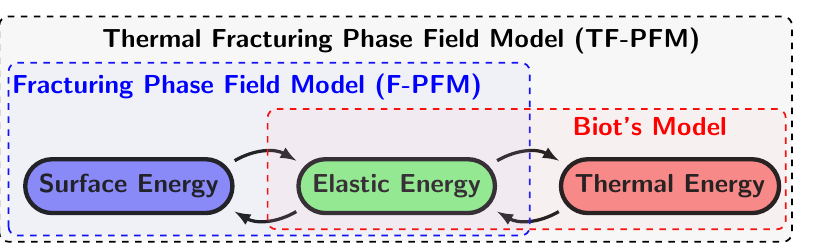
Figure 1. A conceptual diagram of energy balance for Biot’s model, F-PFM, and